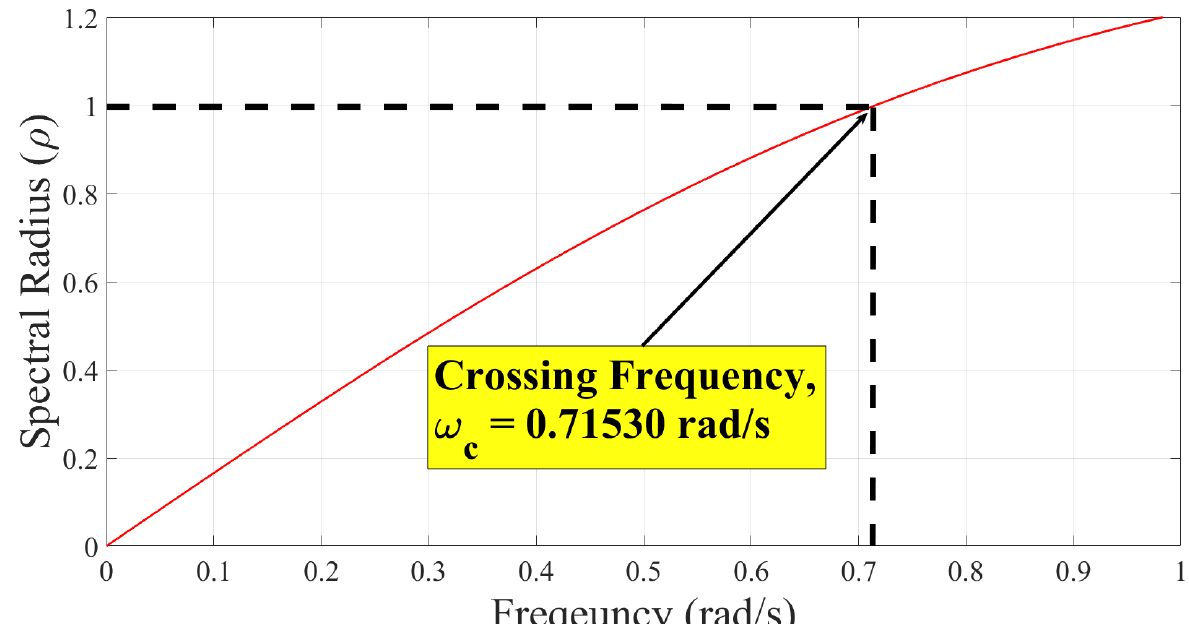
Figure 15. The spectral radius, ρ , against the frequency, ω , for K P = 0.4 and K I = 0.6. Case study 3 with K P = 0.05 and K I = 0.05: The DM estimated using the method provided in reference [18] is 31.704 s, while it was 31.895 s with the proposed method. The frequency response of the two-area LFC system was illustrated in Figures 16 and 17, taking into account the impact of various time delays on area 1 and area 2, while setting K P = 0.05 and K I = 0.05.